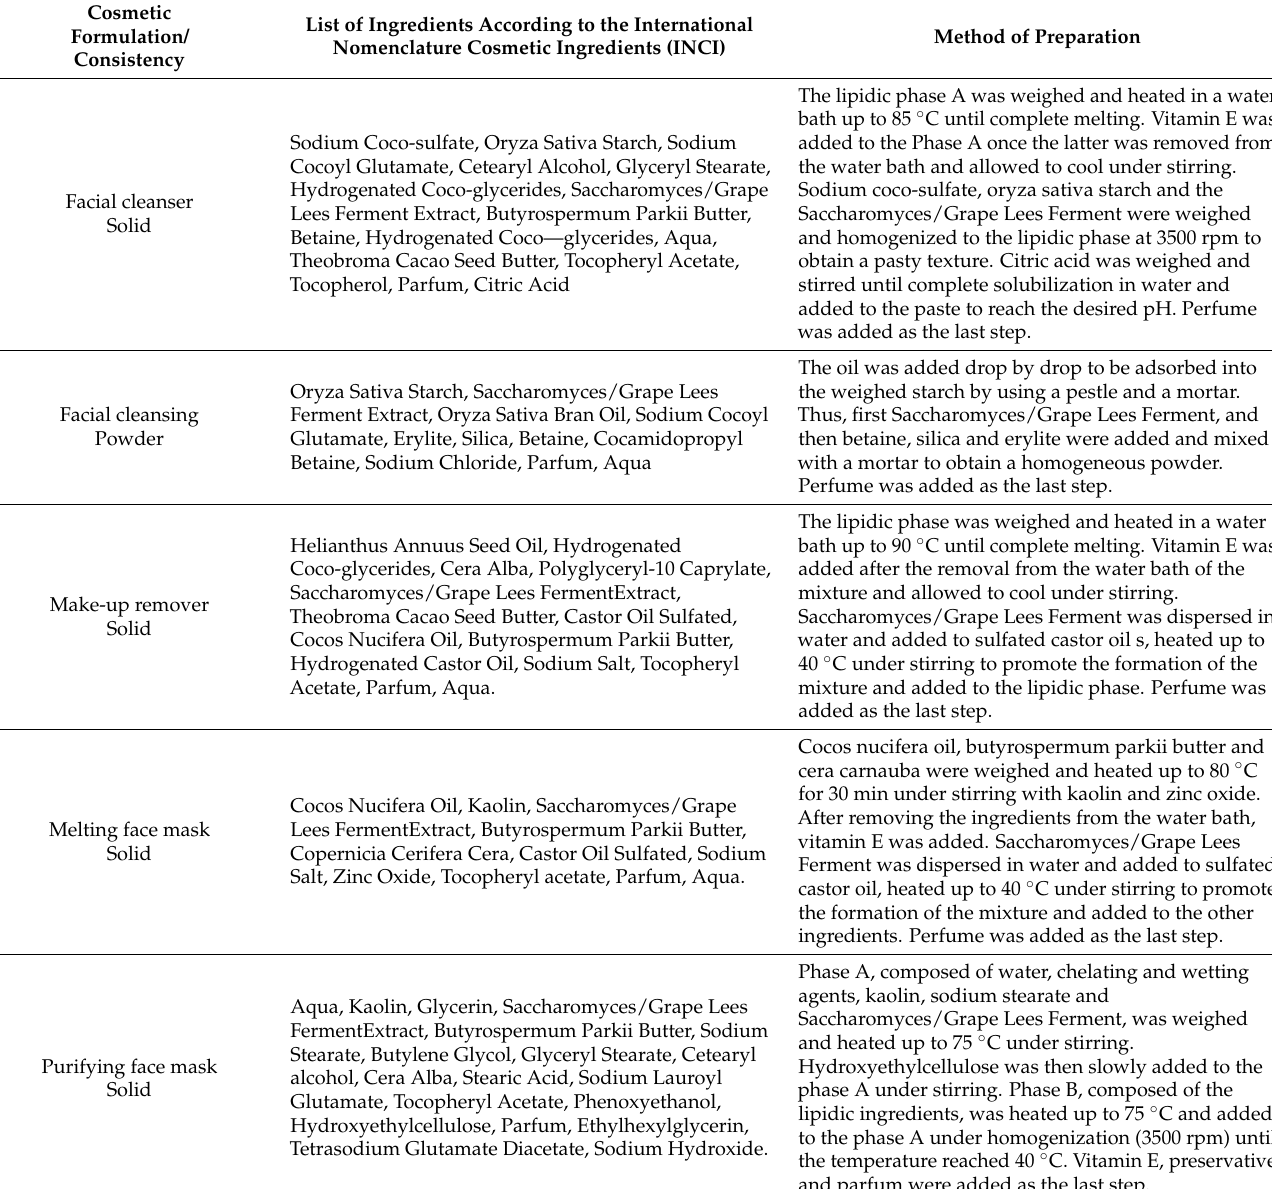
Table 4. List of ingredients and preparation of cosmetic